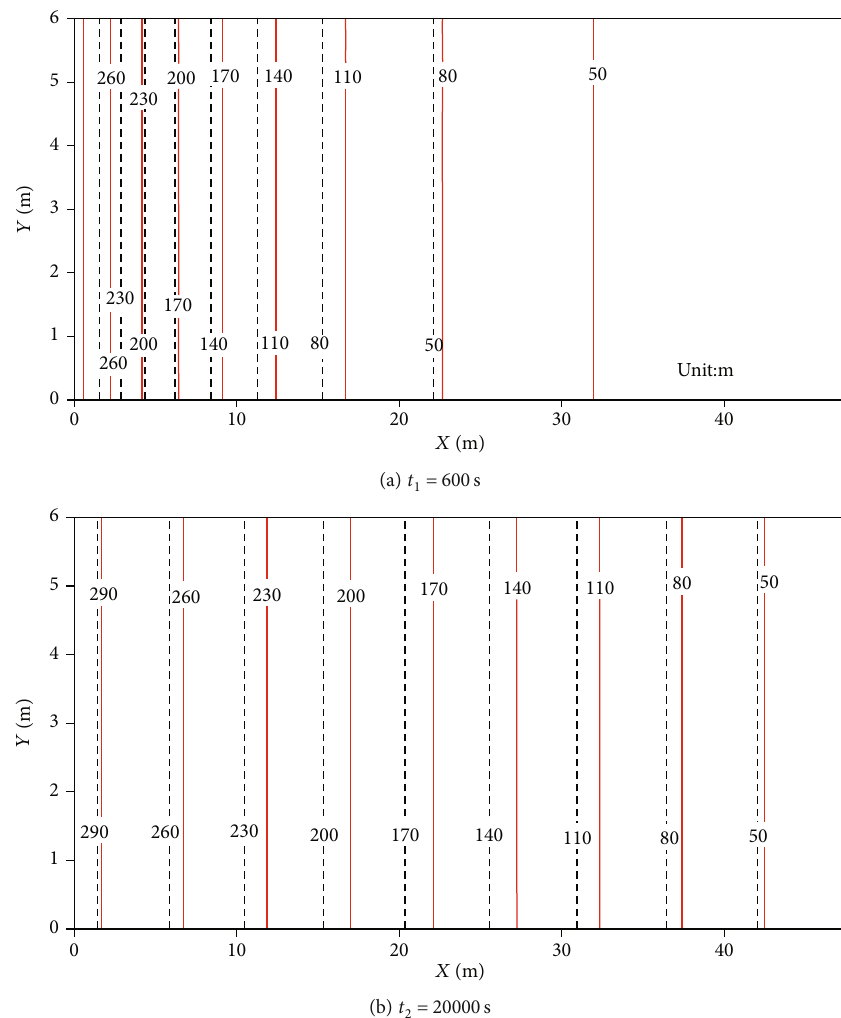
Figure 4: Isometric line of the seepage fi eld in the fi ssure